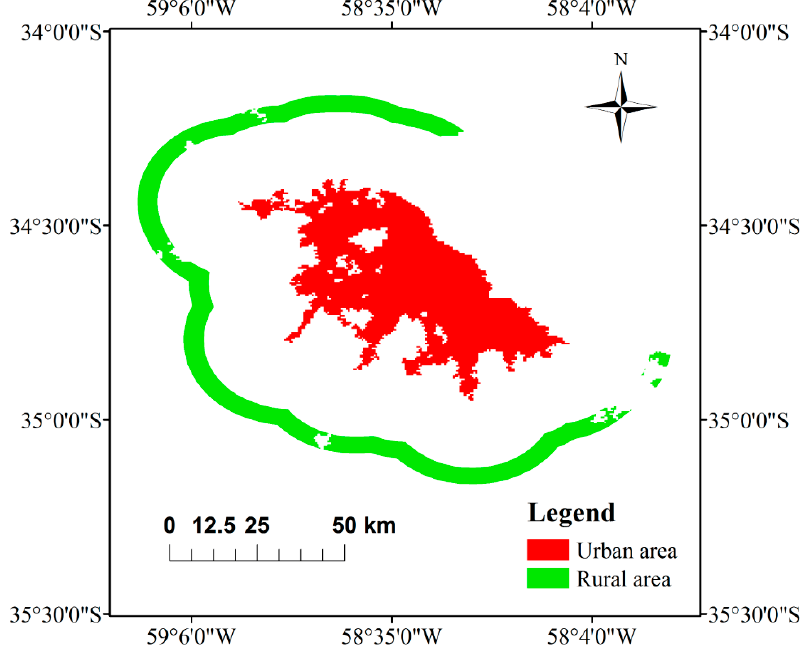
Figure 2. Schematic diagram of urban and rural areas, using Buenos Aires, Argentina as an example.